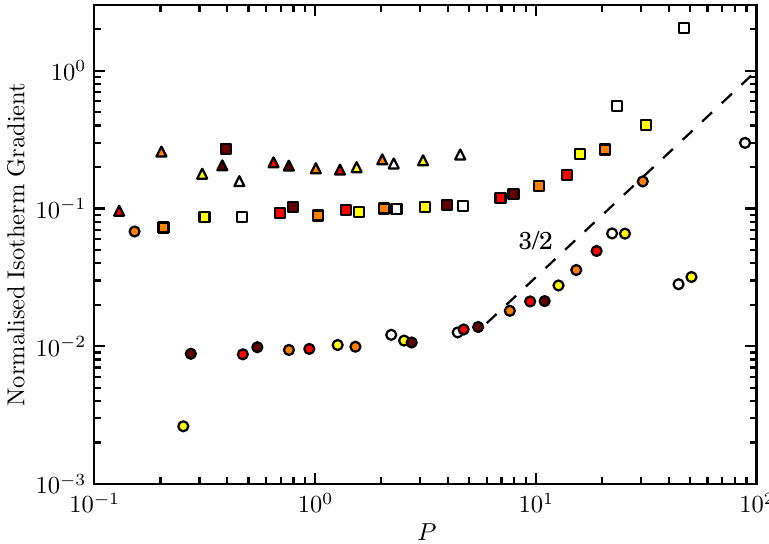
Figure 6. The isotherm gradient, normalised by the gradient of the conductive isotherms, as a function of P . Lower P data is not included as the interior of the annulus is approximately isothermal for low rotation and so the isotherm slope is not well defined. The dashed line shows the predicted dependence of the isotherm gradient on P and has a gradient of 3/2. Symbols have the same meaning as in Figure